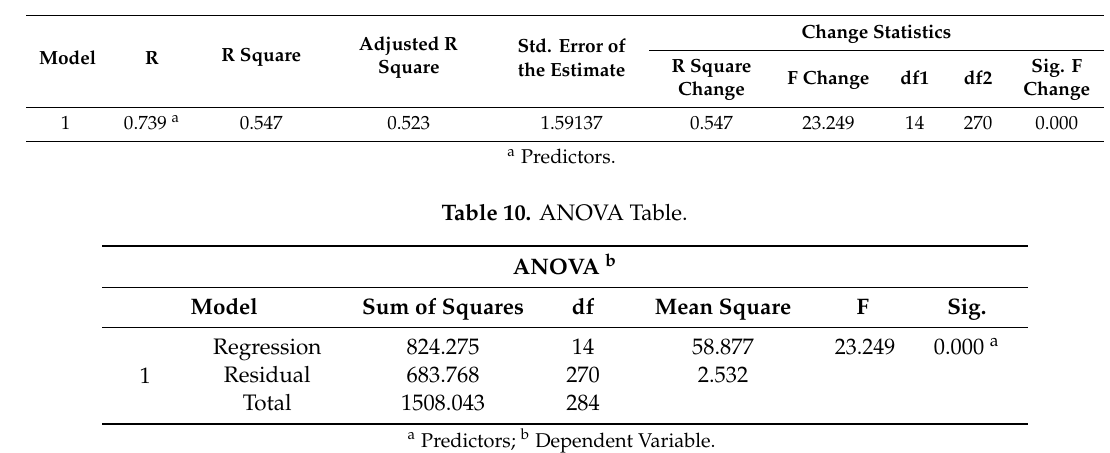
Table 9. Model Summary.